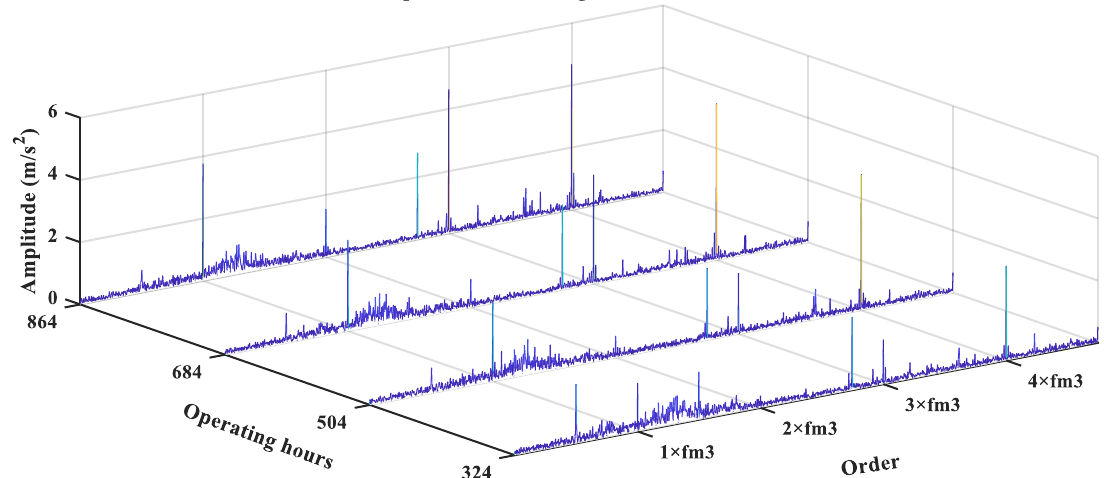
Figure 17. Spectrum of Time Synchronous Averaging (TSA) signal of GB2 vibration under different operating hours.